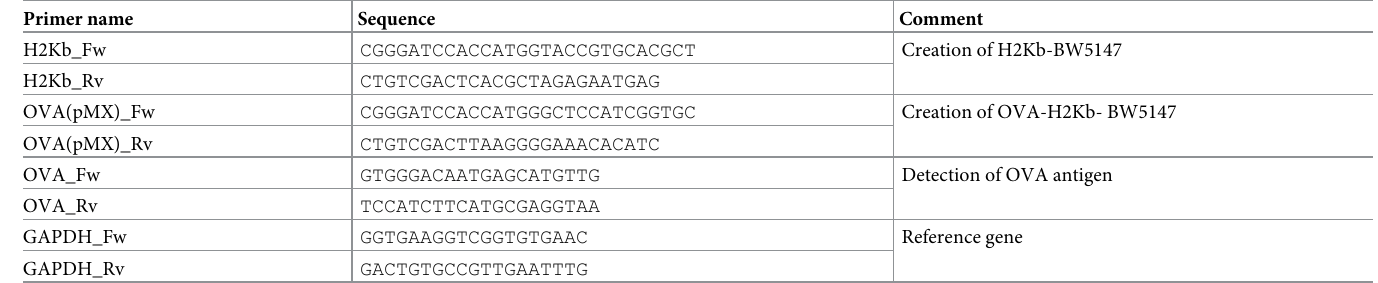
Table 1. Primers used in this